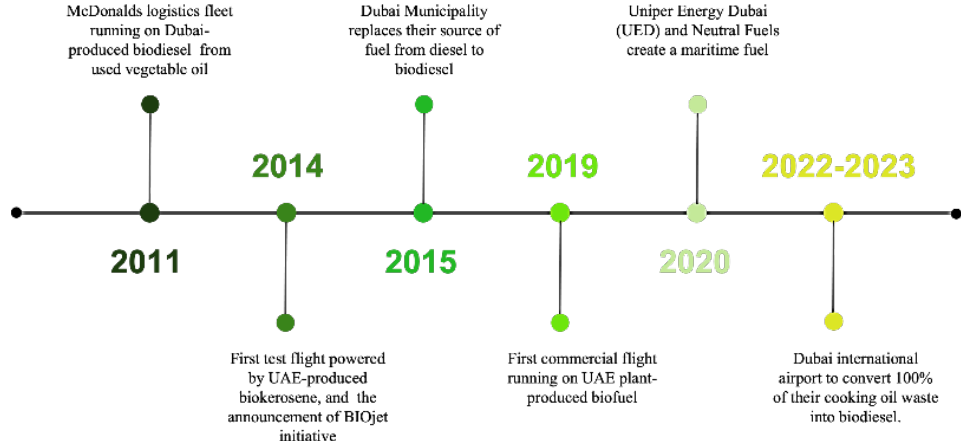
Figure 10. UAE biofuel production timeline.